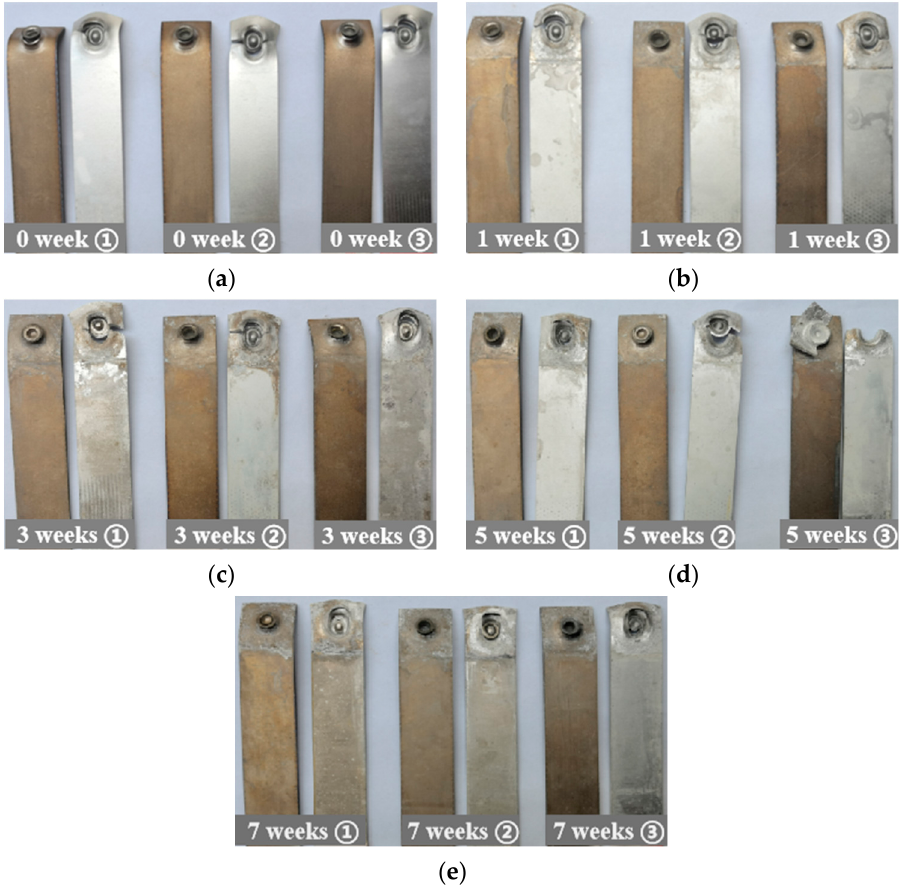
Figure 6. Tensile failure forms of joints at different corrosion times of ( a ) 0 week; ( b ) 1 week; ( c ) 3 weeks; ( d ) 5 weeks; and ( e ) 7 weeks.